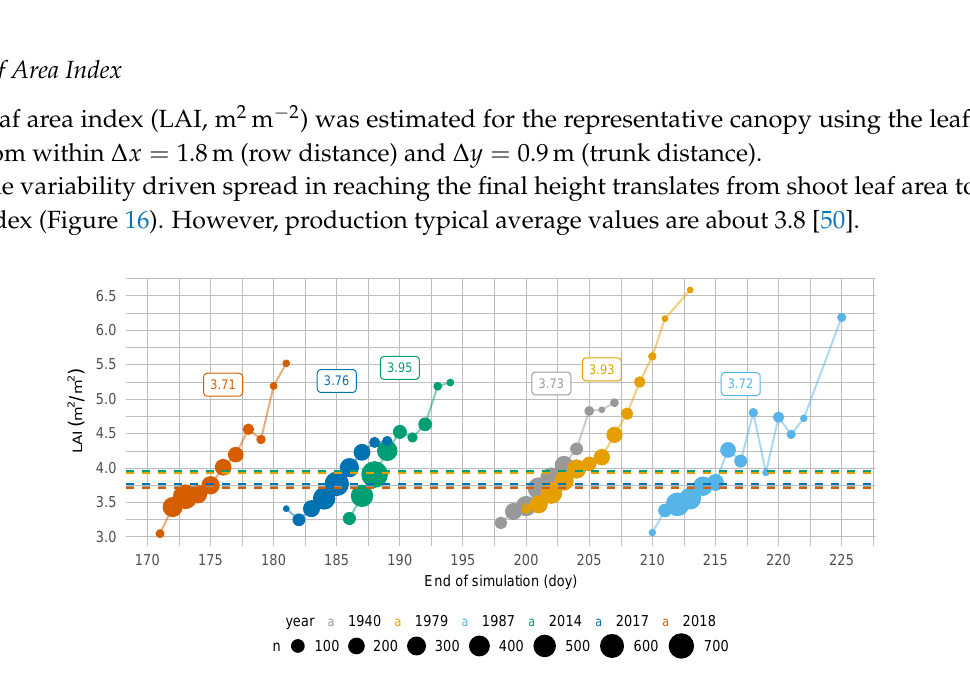
Figure 16. Leaf area index (LAI, m 2 m − 2 ) averages per end of simulation (DOY) and year. Dashed lines and annotation indicate year-wise mean